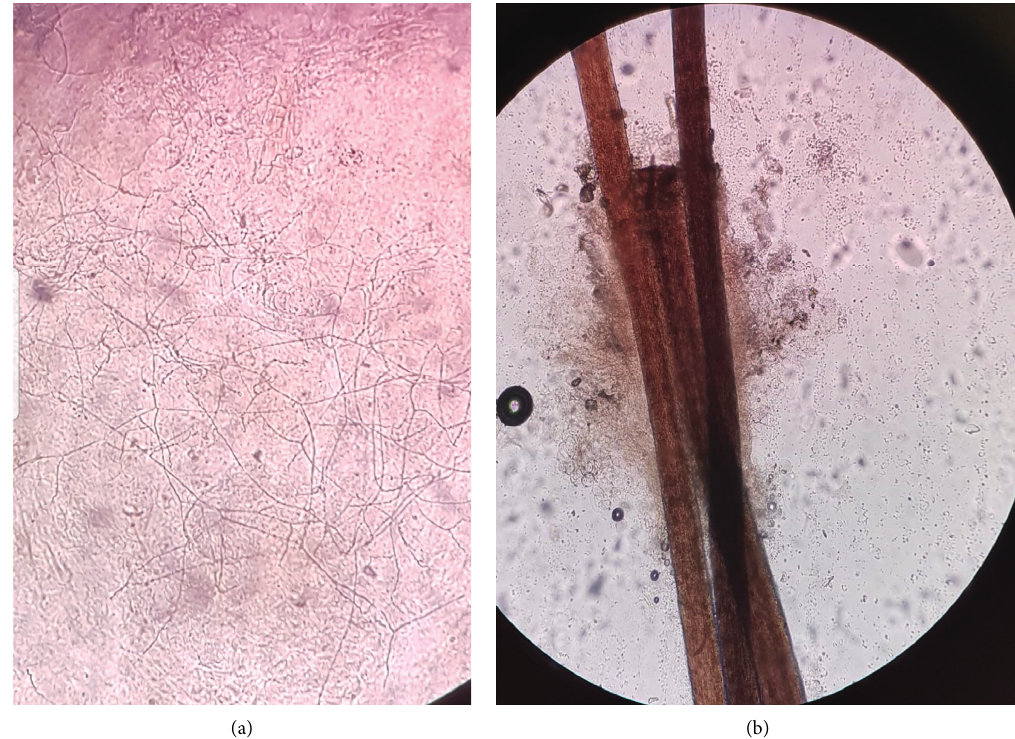
Figure 2: (a)Branching hyphae under KOH wet mount (10x). (b) Ectothrix shown in hair follicle in KOH wet mount